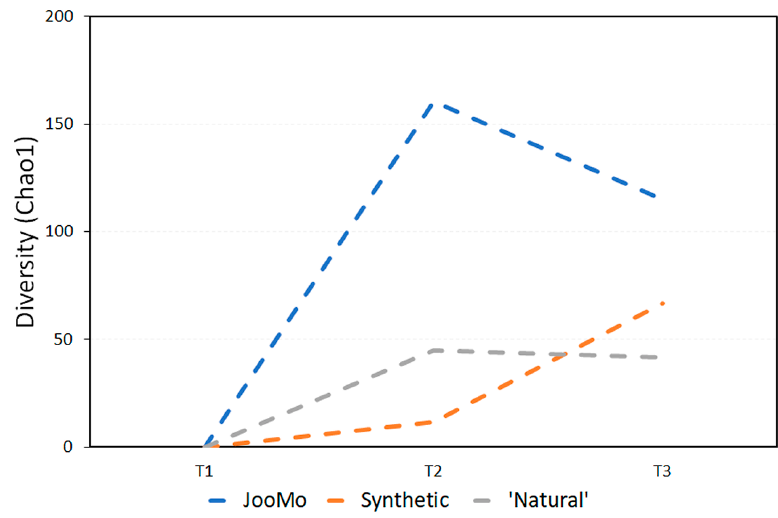
Figure 3. Average change in biodiversity for all time periods, using the Chao1 index. Table 2. Percentage change in Chao1 diversity for all product groups.